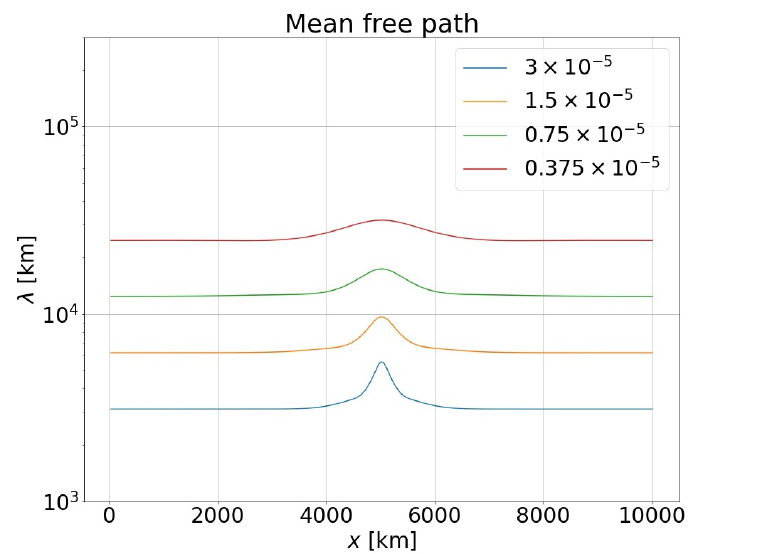
Figure 4. The calculated mean free path of particles in simulations of a coronal loop with the size L = 10,000 km and the spatial cell size ∆ x = 20 km. Different normalization values α are denoted in the legend.